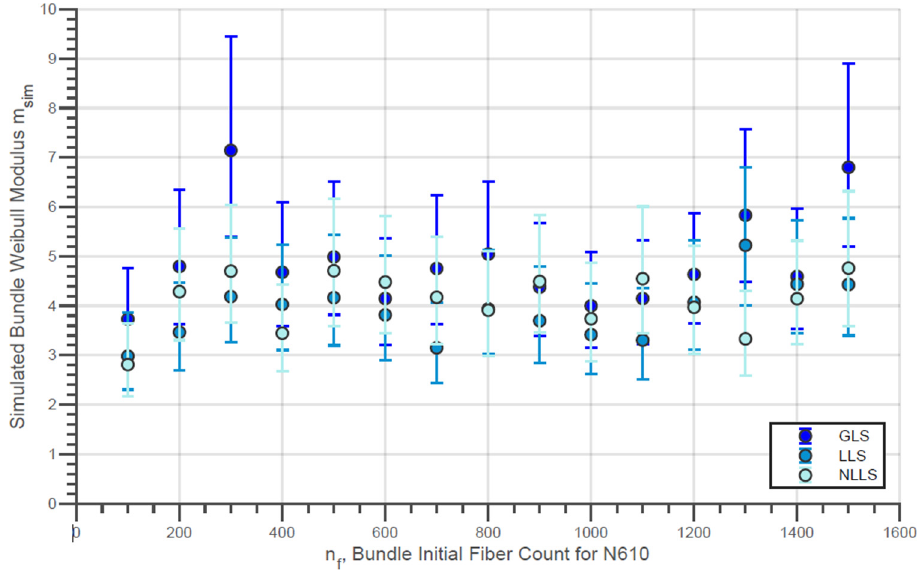
Figure 11. Simulated Weibull modulus for the true strength of fiber bundles of N610 fibers with different load-sharing models.